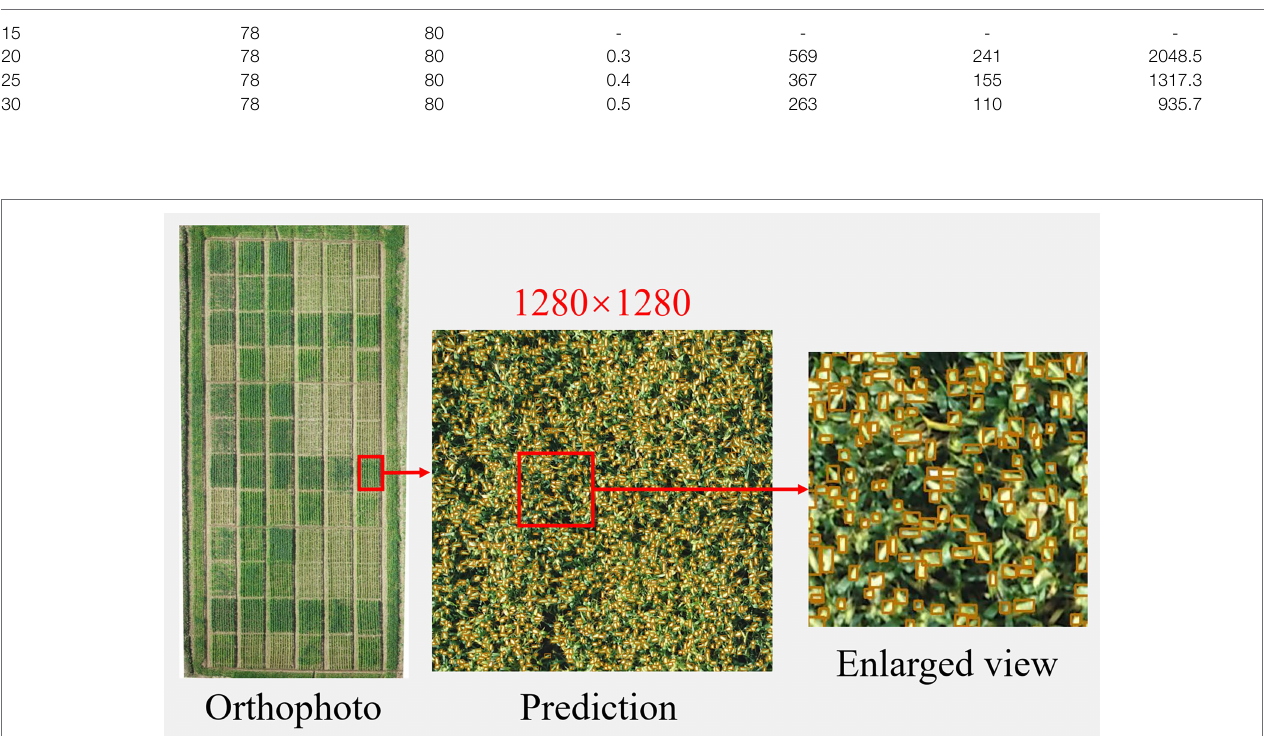
TABLE 5 | Parameters corresponding to different flight altitudes of UAVs. Heading overlap Flight altitude (m) rate